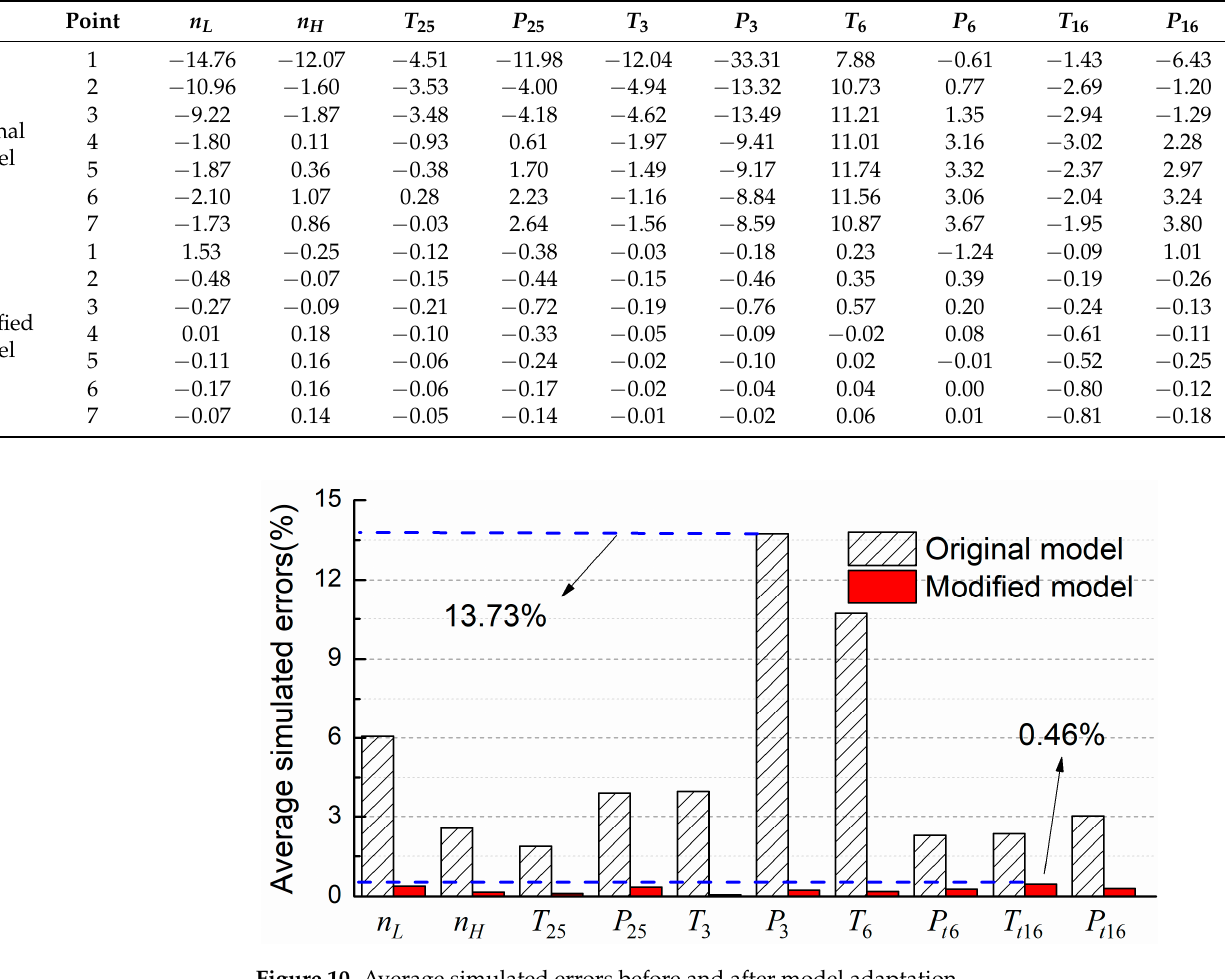
Figure 10. Average simulated errors before and after model adaptation.